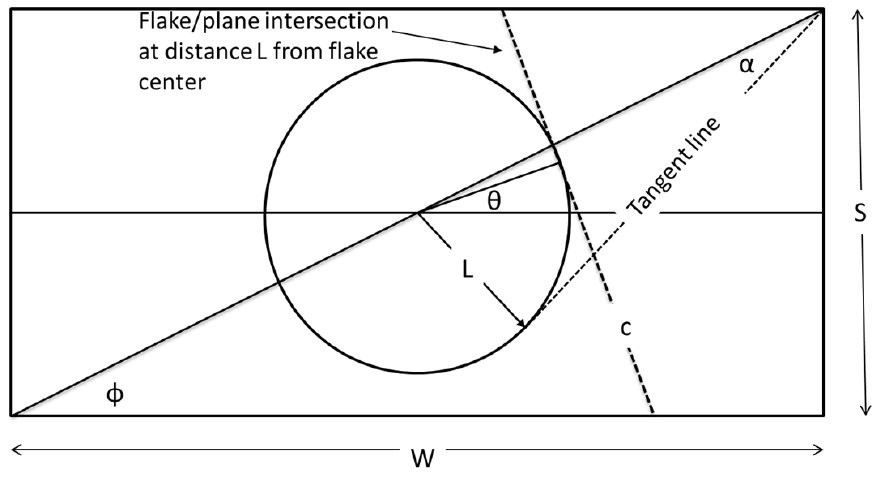
Figure 3. Basic geometrical features of the problem. The intersection between the cutting plane and the plane of the flake (line (c) in the schematic) will be tangent to a circle of radius L , centered at the center of the flake. The counter-clockwise angle formed between the long axis of the rect- angle and line c is π /2 + θ . Thus, θ = 0 corresponds to line (c) being perpendicular to the long axis of the rectangle, and, when θ = π /2, line (c) is parallel to the long axis of the rectangle. Reprinted from Papathanasiou et al.